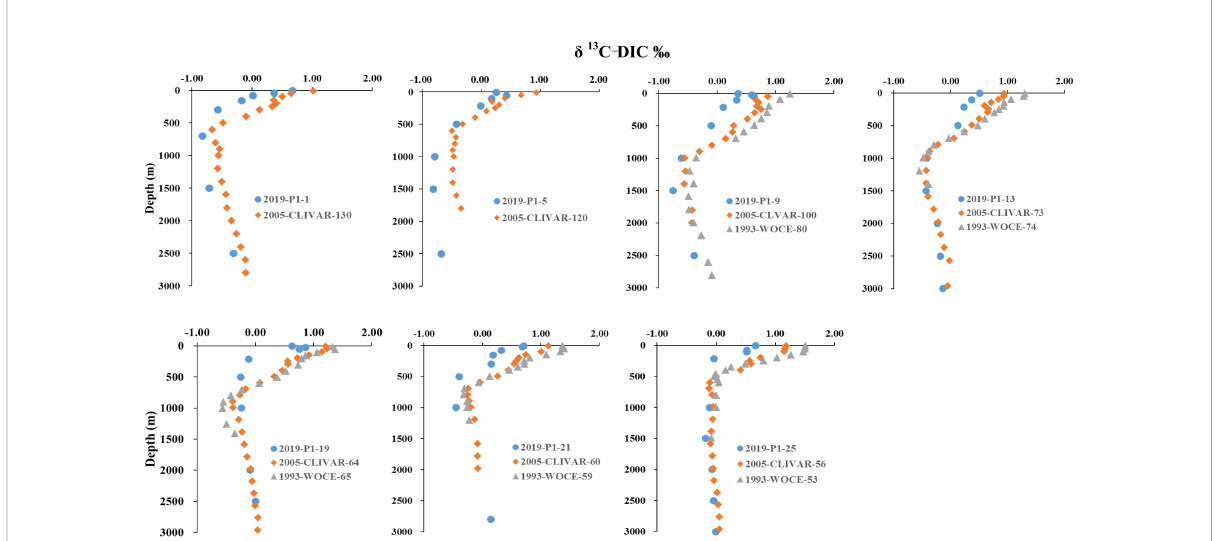
FIGURE 7 Comparison of the depth pro fi les of the d 13 C-DIC values measured for stations along transect P1 in 2019 in our study with those obtained at nearby stations along CLIVAR line P10N in 2005 and WOCE line P10 in 1993 in the upper 3,000 m of water in the northwestern NP. The data for lines P10N and P10 are from the GLODAP database